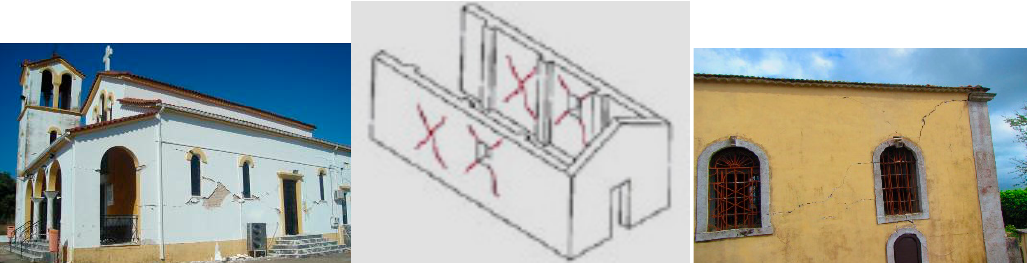
Figure 5. Typical damage patterns of longitudinal walls.